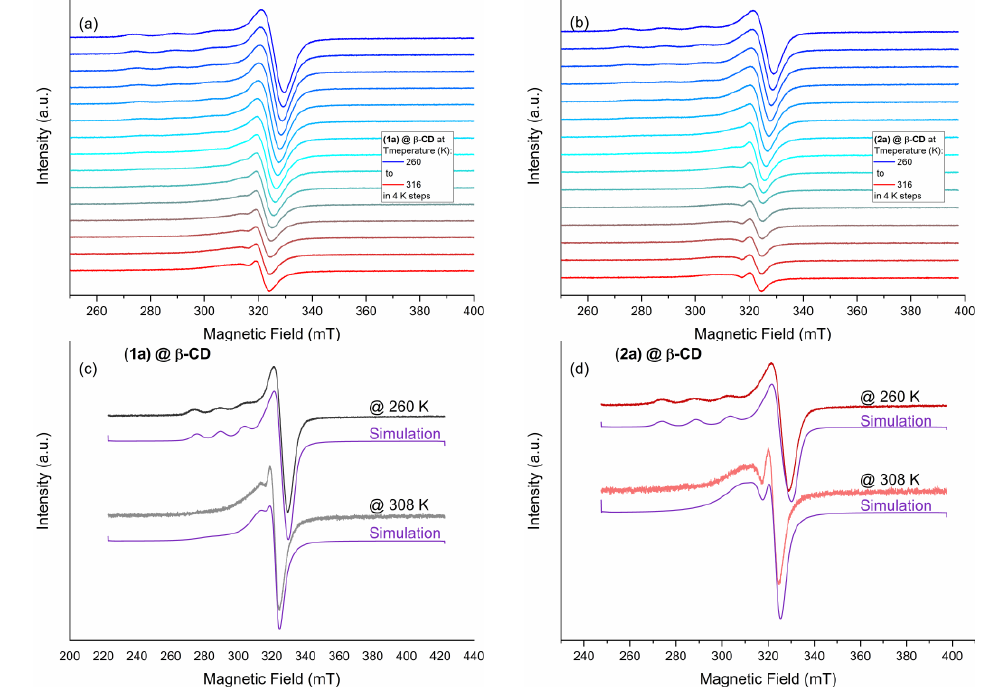
Figure 10. EPR spectra of ( 1a )@ β -CD ( a ) and ( 2a ) @ β -CD ( b ) dissolved in DMSO with a 100 mM concentration measured from 260 to 316 K with a 4 K step. Simulated EPR spectra together with the measured data recorded at 260 and 308 K for ( 1a )@ β -CD ( c ) and ( 2a ) @ β -CD ( d ), respectively. All measurements were carried out at a microwave frequency of 9.45 GHz. Table 1. Simulation EPR parameters for ( 1a )@ β -CD and ( 2a )@ β